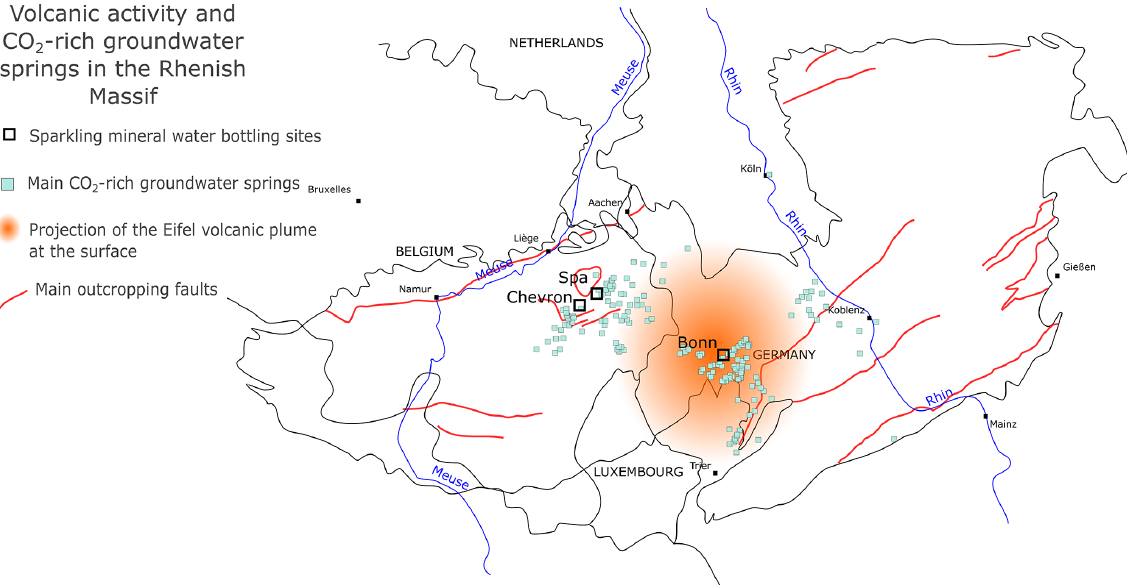
Figure 2. Occurrences of CO 2 -rich groundwater springs in the Rhenish Massif, together with the main bottling sites. The spring locations were compiled from May et al. (1996), Bräur et al. (2013) and internal data from Spadel. The projection of the Eifel volcanic area is depicted after Bräur et al.